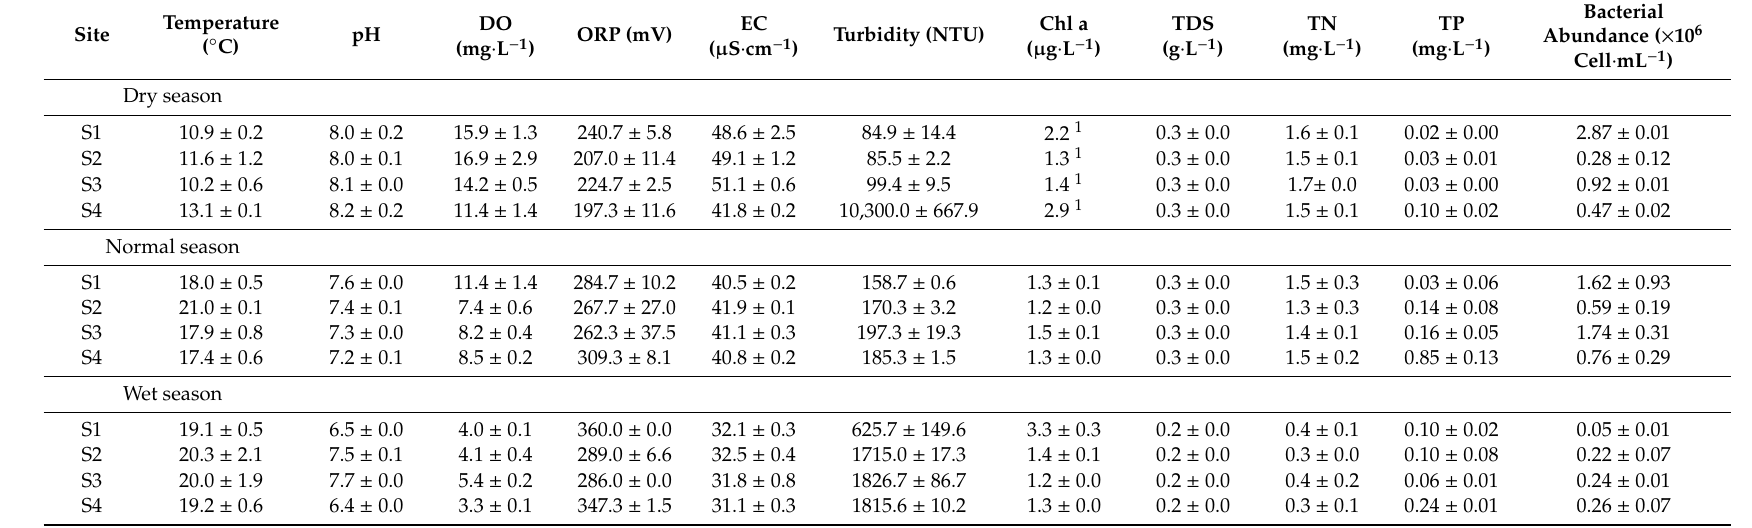
Table 1. Physical and chemical characteristics (mean ± standard deviation) in water upstream and downstream of Gongguoqiao hydroelectric